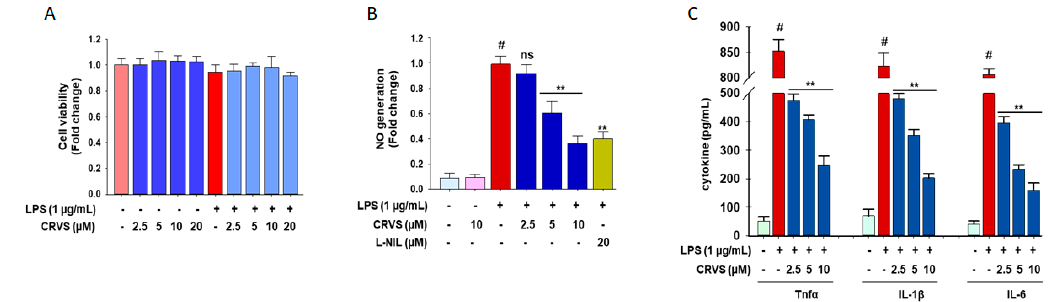
Figure 3. The anti-inflammatory effects of CRVS in LPS-stimulated murine peritoneal macrophages. Thioglycolate (TG)-elicited macrophages were pretreated with the indicated concentrations of CRVS (2.5, 5, 10, and 20 μ M) for 1 h following treatment with LPS (1 μ g/mL) for 24 h. Effects of CRVS on the cell viability ( A ); the production of NO ( B ); and TNF- α , IL-1 β , and IL-6 ( C ) were examined. # p < 0.01 as compared with vehicle-treated control; ** p < 0.05 as compared with LPS alone.